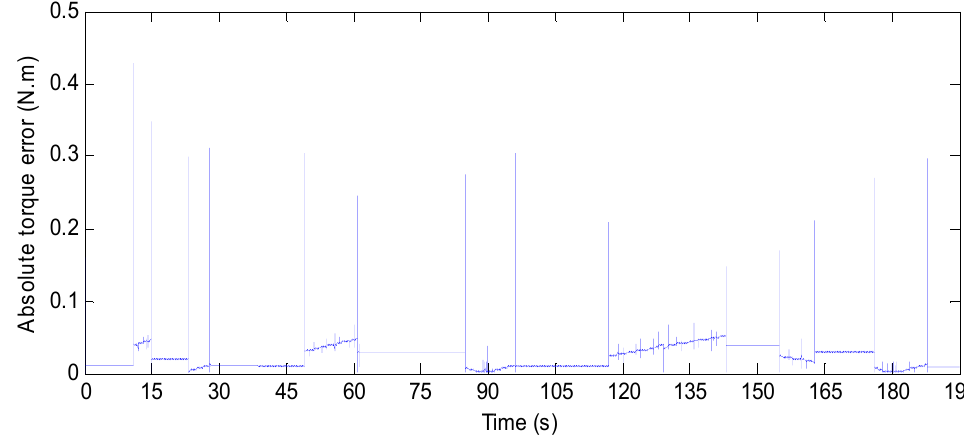
Figure 27. BEV torque response and its reference for ECE driving cycle.